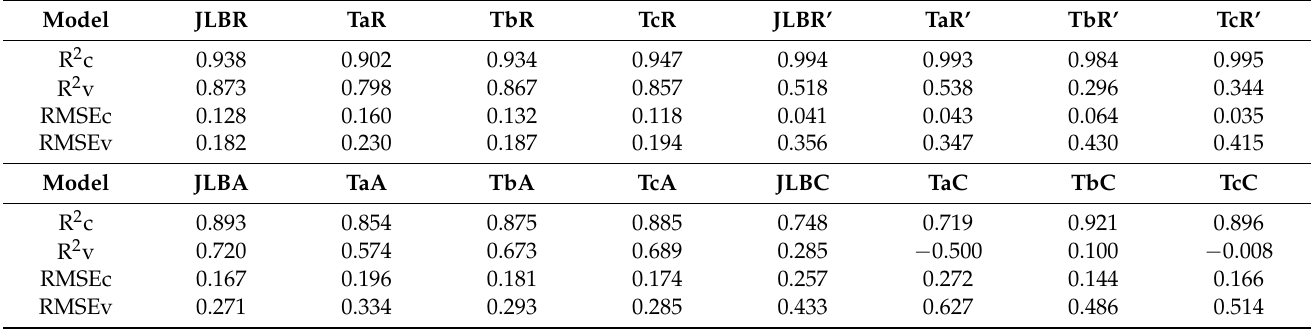
Table 4. Estimation accuracy of PLS models in the soil temperature control experiment.